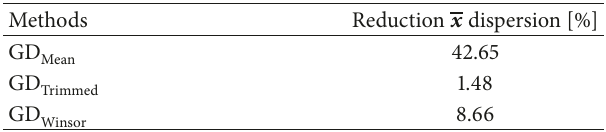
Table 64: G-h with 100 points.